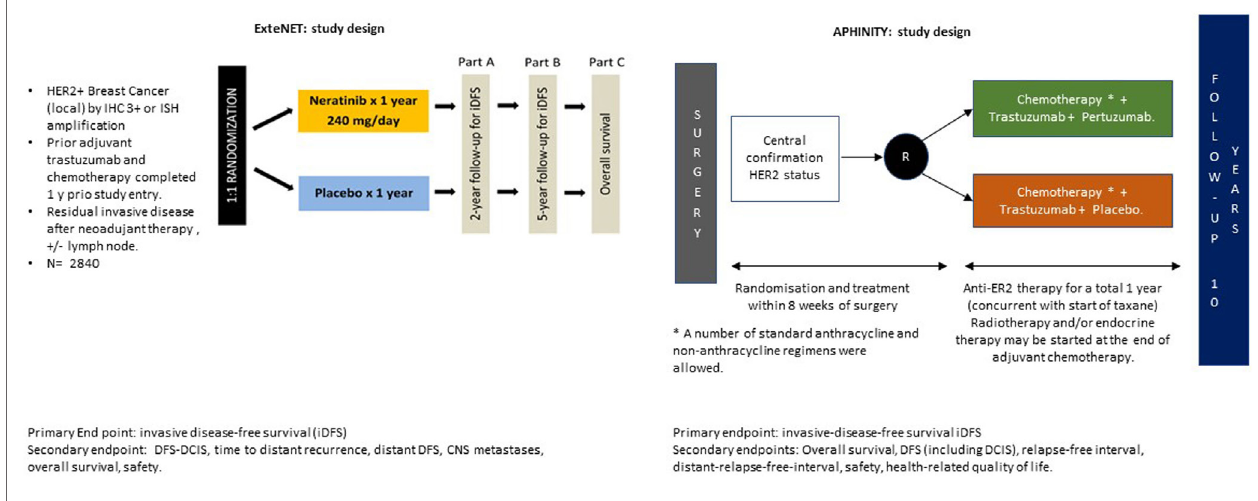
FiGURE 1 | ExteNet and APHINITY trial